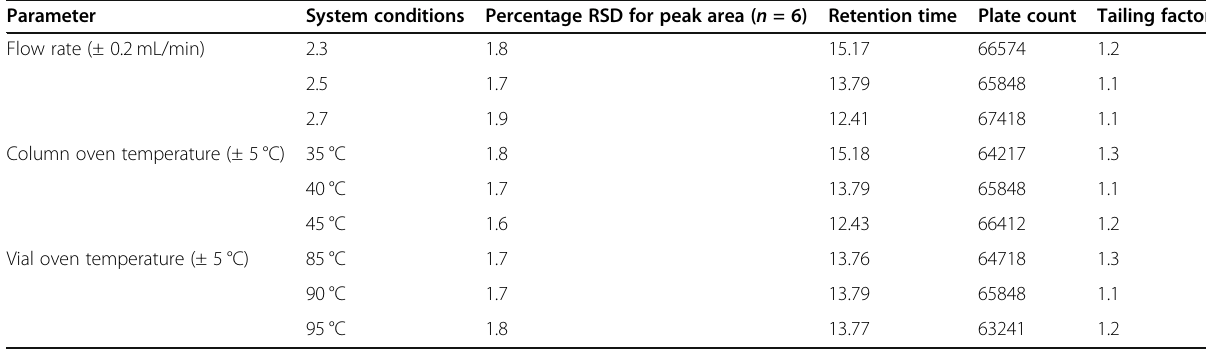
Table 25 Robustness study results of ethyl acetate